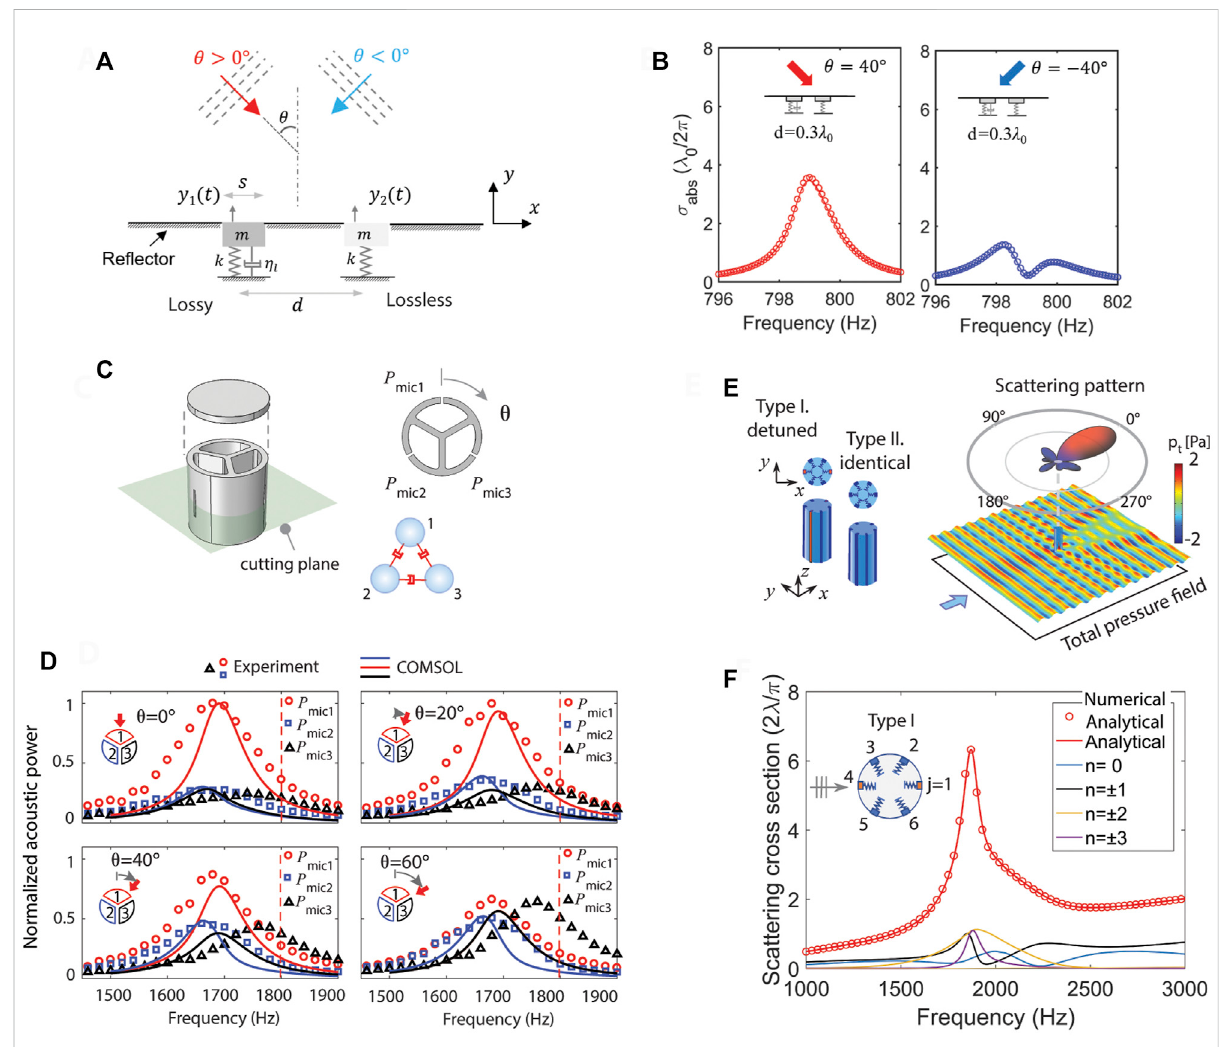
FIGURE 7 Coupled resonators in open fi eld. (A) Asymmetric absorption scattering. (B) Corresponding absorption scattering cross section spectra. (C) Coupled resonators-based acoustic direction sensor. (D) Acoustic power spectra in each resonator of the direction sensor. (E) Coupled resonators for acoustic superscattering. (F) Scattering cross section spectra of the superscatter. Reprint (A,B) from Ref. [44], (C,D) from Ref. [54], (E,F) from Ref.